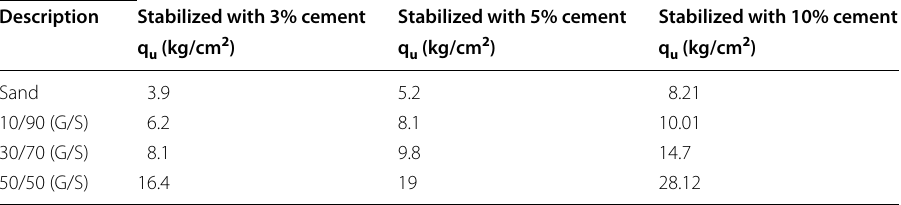
Table 4 Unconfined compressive strength parameter of stabilized SM and CG–SP blends